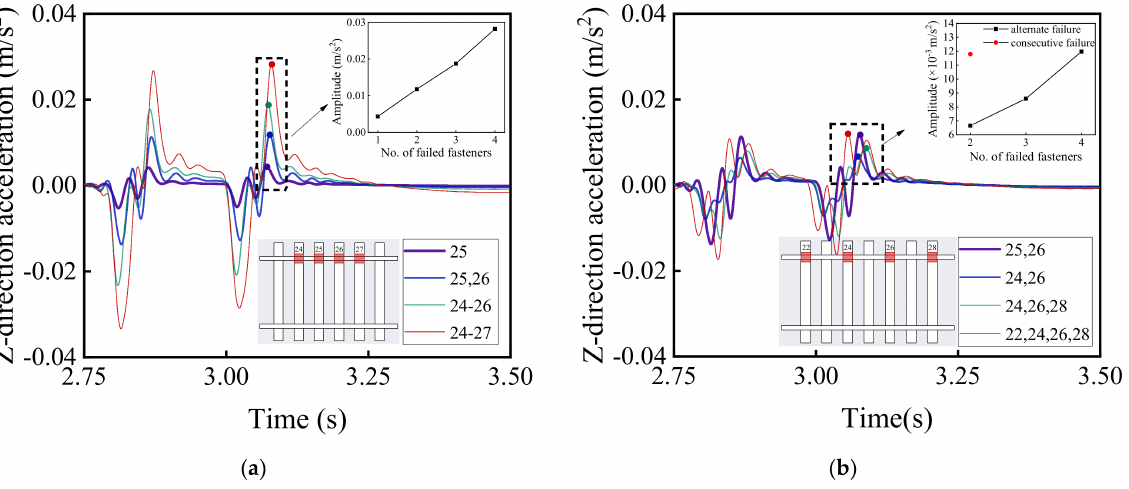
Figure 16. Model-calculated time history curves of vertical (Z-direction) acceleration response of car bodies with ( a ) single-side consecutive and ( b ) single-side alternate fastener failures.